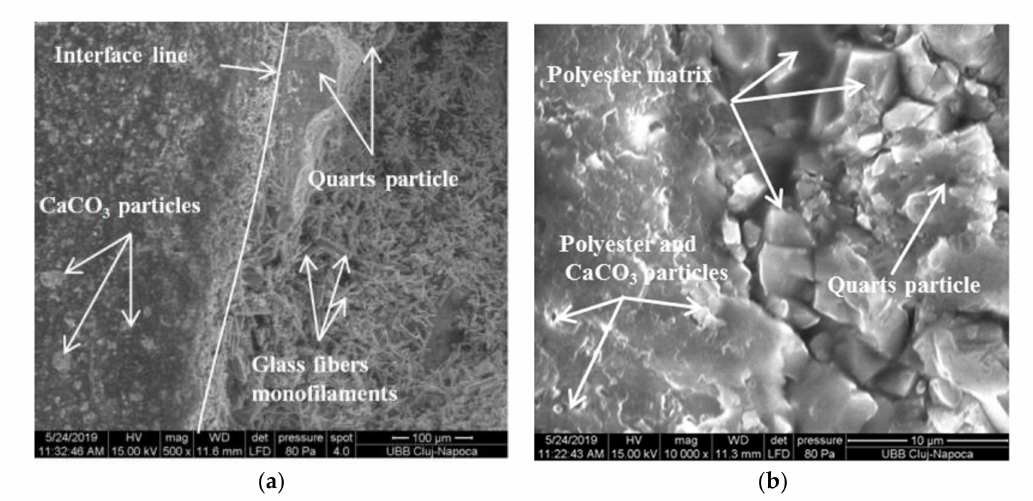
Figure 19. SEM images of the interface between composite 1 and the composite 2: ( a ) 1:1 × 10 − 4 m scale; ( b ) 1:1 × 10 − 5 m